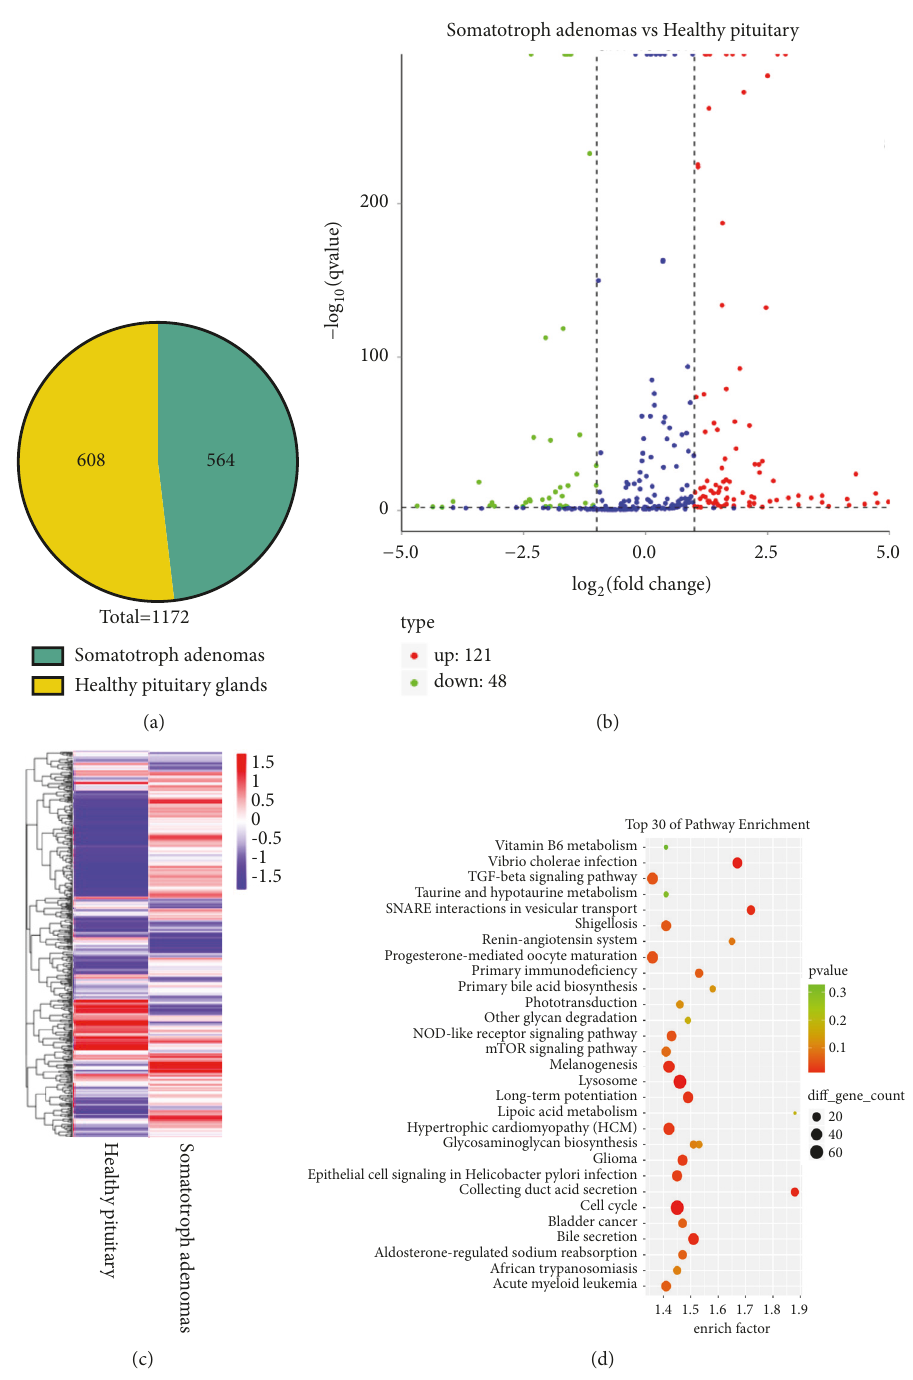
Figure 1: MiRNA expression profiling of somatotroph adenomas and healthy pituitary samples. (a): Exosome sequence profiling found 564 miRNAs in somatotroph adenomas and 608 healthy pituitary samples. (b) The volcano plot showed differently expressed miRNAs between somatotroph adenomas and healthy pituitary samples, red point indicated the 121 upregulated miRNAs, and green point indicated the 48 downregulated miRNAs in somatotroph adenomas. Blue point represented the miRNAs that were no difference between somatotroph adenomas and healthy pituitary samples. (c) Cluster analysis of differently expressed miRNAs between somatotroph adenomas and healthy pituitary samples. (d) 511 target mRNAs of hsa-miR-320a and hsa-miR-423-5p were enriched in different signal pathways by